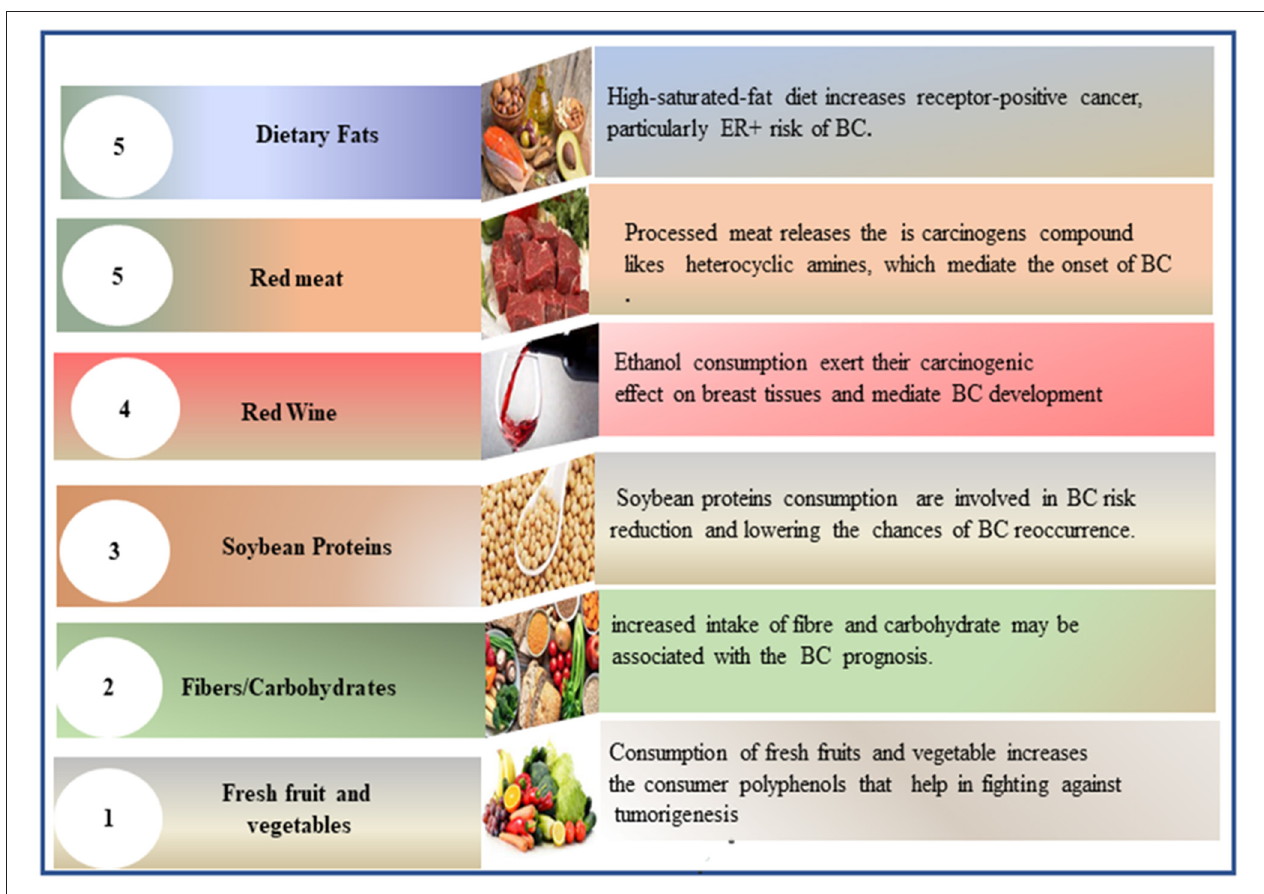
FIGURE 2 | Figurative description of dietary factors involved in BC incidence prevention and recurrence. BC, breast